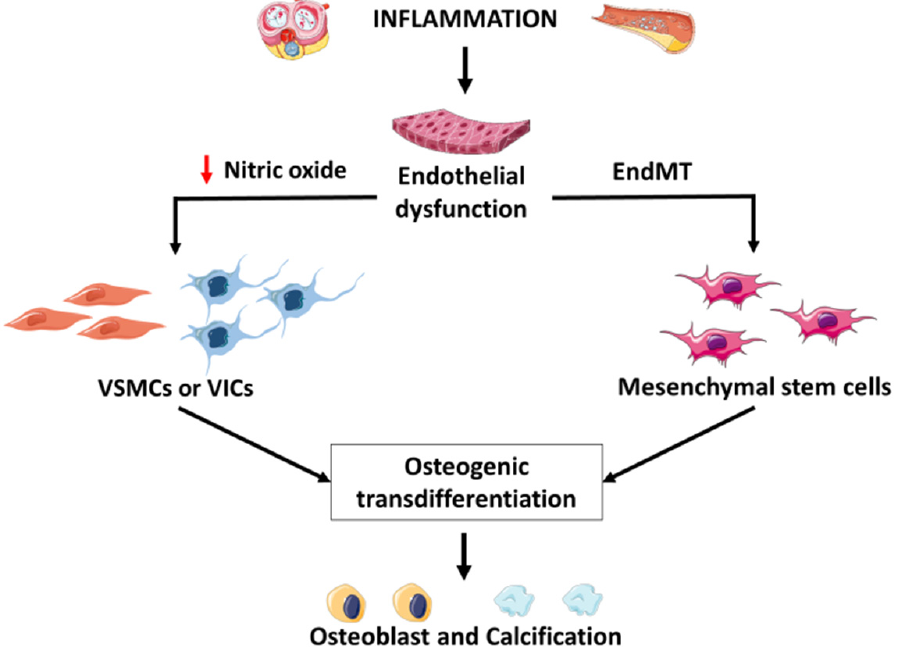
Figure 4. Mechanism of inflammatory vascular and valvular calcification. Vascular smooth muscle cells = VSMCs; valvular interstitial cells = VICs; endothelial-to-mesenchymal transition = EndMT; VSMC = Vascular smooth muscle cell; VICs = valvular interstitial cells; EndTM = endothelial-to- mesenchymal transition.